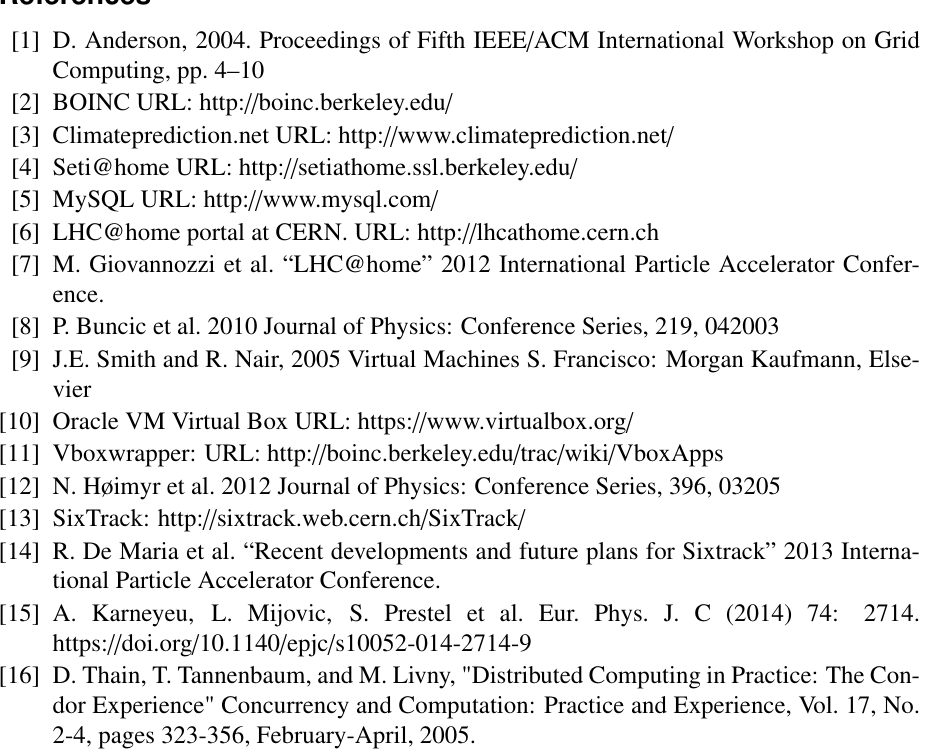
Figure 3. Increase of ATLAS jobs following storage